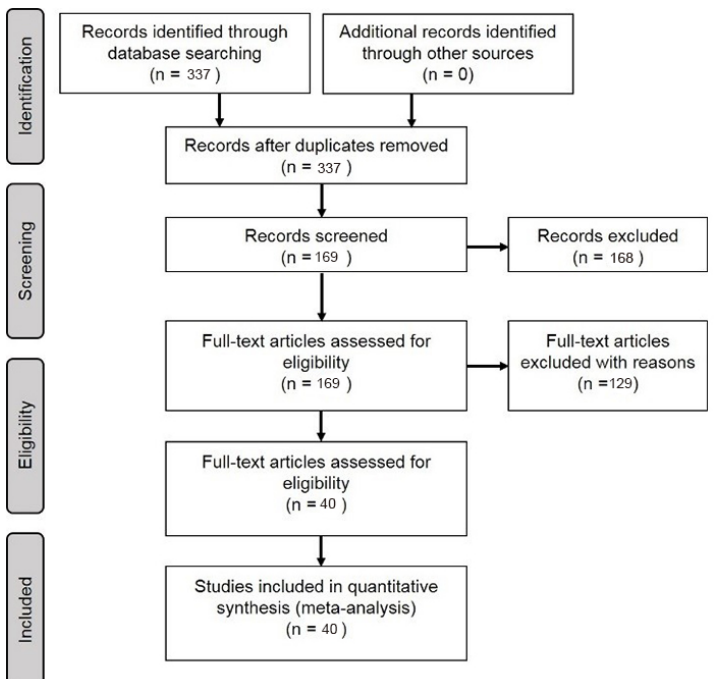
Figure 1. PRISMA-based paper filtering